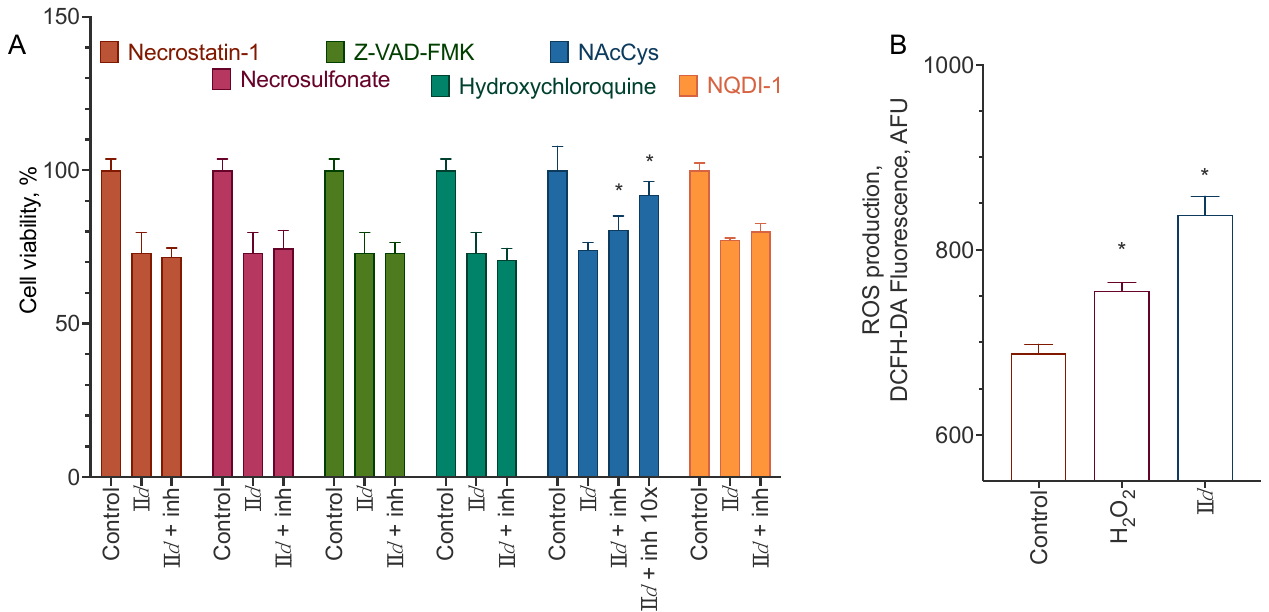
Figure 7. Cell death mechanism of the II d compound for the MDA-MB-231 cell line. ( A ) Effect of necroptosis (necrostatin-1, 100 µ M, and necrosulfonate, 1 µ M), apoptosis (Z-VAD-FMK, 10 µ M), autophagy (hydroxychloroquine sulfate, 1 µ M), and ASK1 (NQDI-1, 10 µ M) blockers and ROS scavenger (N-Ac-Cys, 0.05 or 0.5 mM + 50 mM HEPES for pH stabilization) on the cytotoxicity of 100 µ M of II d . 24 h incubation time, MTT assay data, mean ± standard error, n = 3 amalgamated experiments. ( B ), ROS accumulation after the treatment of the cells with 5 mM of H 2 O 2 or 100 µ M of II d . 24 h incubation time, DCFH-DA fluorescence data, n = 3 amalgamated experiments. *